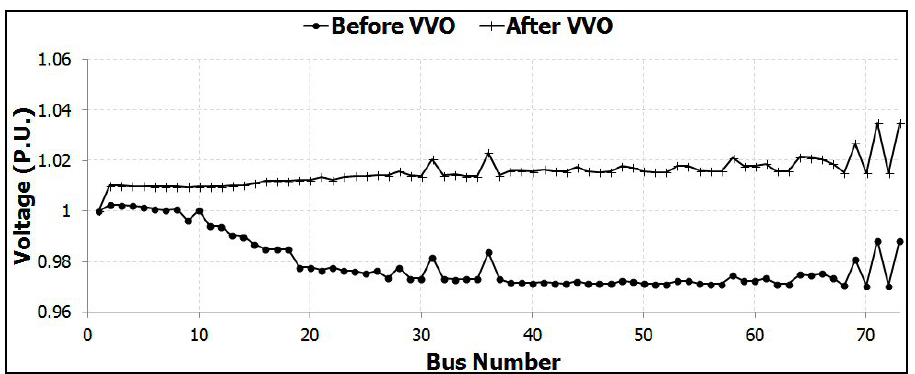
Figure 9. Voltage profile comparison for Case